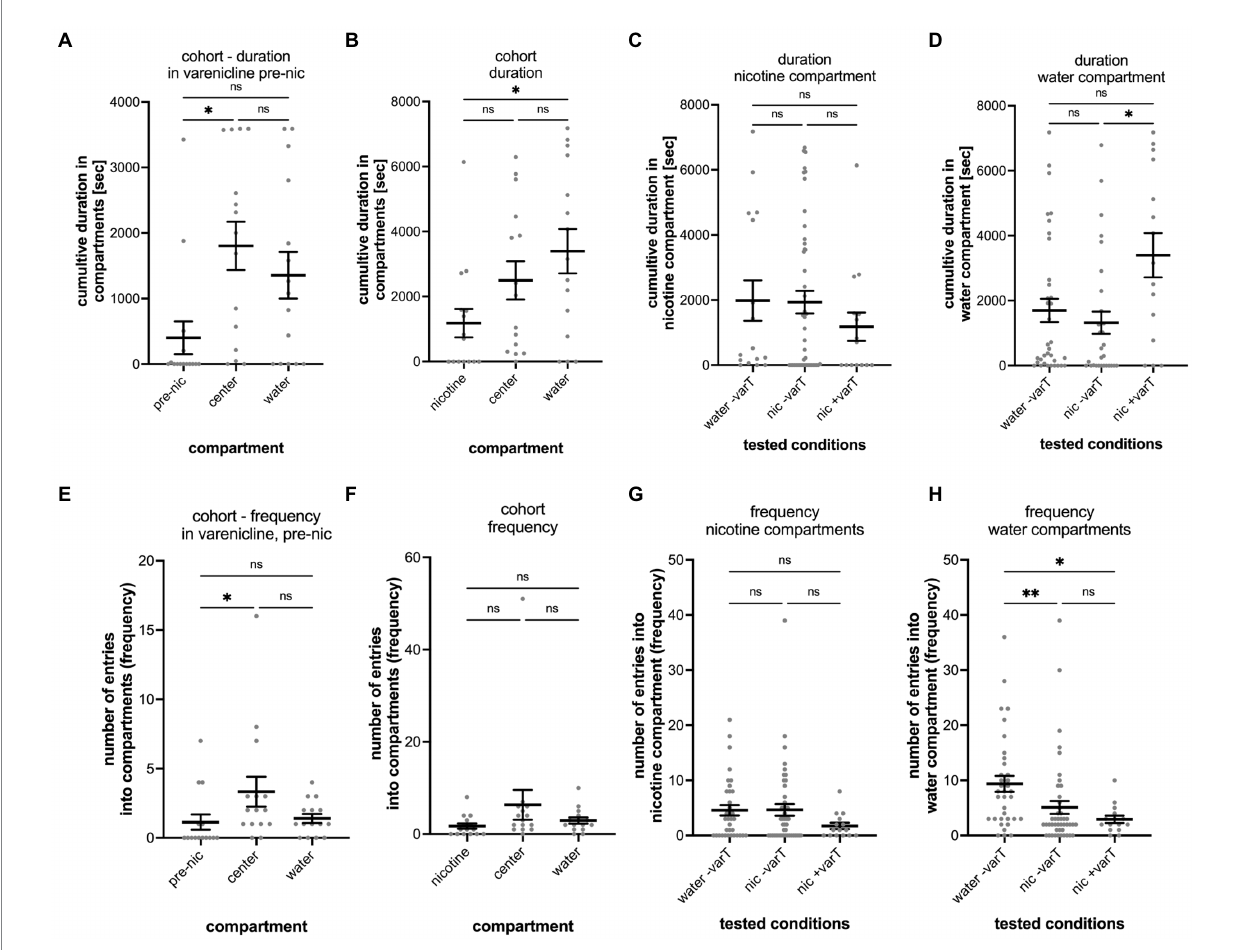
FIGURE 6 Analysis of varenicline treatment experiments. The results of the entire cohort ( n = 15) are shown in (A) for the cumulative duration in the nicotine (pre-nic), center and water compartments during the 1-h varenicline phase before addition of nicotine into the nicotine compartment (pre-nic). The difference between the cumulative duration in the nicotine and center compartment was significant ( p = 0.0037) but not between the center compartment and the water compartment ( p = 0.9581) and the pre-nicotine compartment and the water compartment ( p = 0.0766). (B) Shows the cumulative duration in the nicotine nicotine, center, and water compartments in varenicline after addition of nicotine into the nicotine compartment (nicotine). The cumulative duration in the water increased (nicotine vs. water, p = 0.0307) whereas the duration in the center compartment decreased (nicotine vs. center, p = 0.2432) and was not significantly different as before the addition of nicotine. (C) No difference was found between the three experimental conditions for the cumulative duration in the nicotine compartment. (D) The cumulative duration in the water compartment in varenicline and after nicotine addition (nic + varT) was significantly larger than the without varenicline (nic -varT) ( p = 0.0198). (E) Comparison of the number of entrances (frequency) into the nicotine, center and water compartment during varenicline treatment and before addition of nicotine shows a significant difference between the nicotine and center compartment ( p = 0.0242). (F) Addition of nicotine eliminated this difference. (G) No differences for the number of entrances into the nicotine compartment were found when comparing the different treatments. (H) Nicotine decreased the number of entrances into the water compartment without (water –varT vs. nic –varT, p = 0.0021) and with varenicline treatment (nic –varT vs. nic + varT; p = 0.0161). Varenicline did not change the number of entrances with nicotine in the nicotine compartment ( p = 0.6111). Individual data points are shown with the mean ±SEM. Statistical significance was